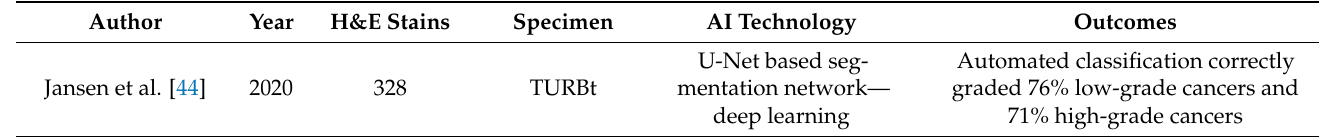
Table 3. Artificial intelligence technologies applied to diagnosis and molecular subtyping